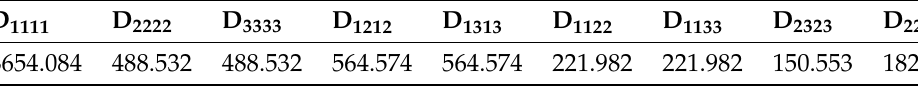
Figure 7. Orientations definition of Glulam. Table 1. Corresponding elastic properties of